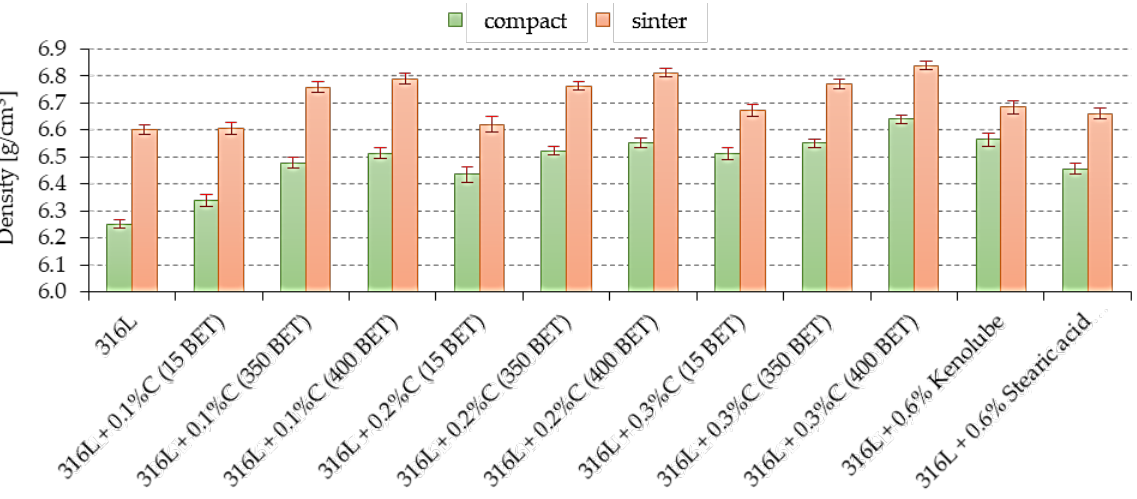
Figure 4. The compacts and sinters densities depend on the percentage composition of mixtures.